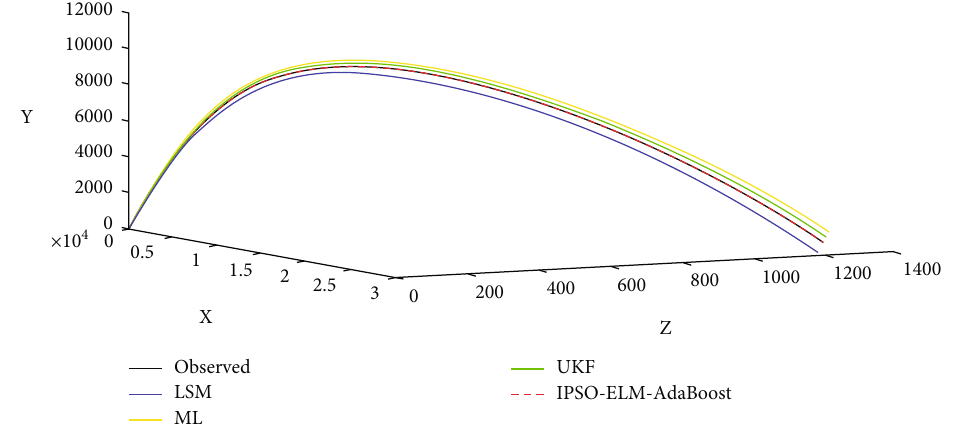
Figure 13: Results of ballistic Table 6: Results of four algorithms.